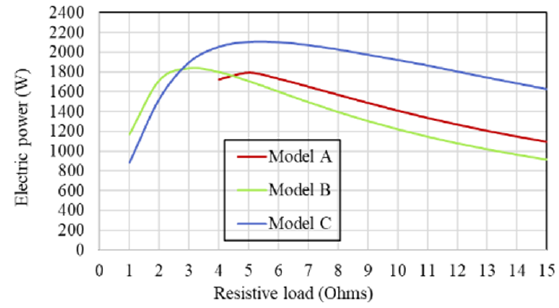
Figure 20. Electric power versus resistive load.